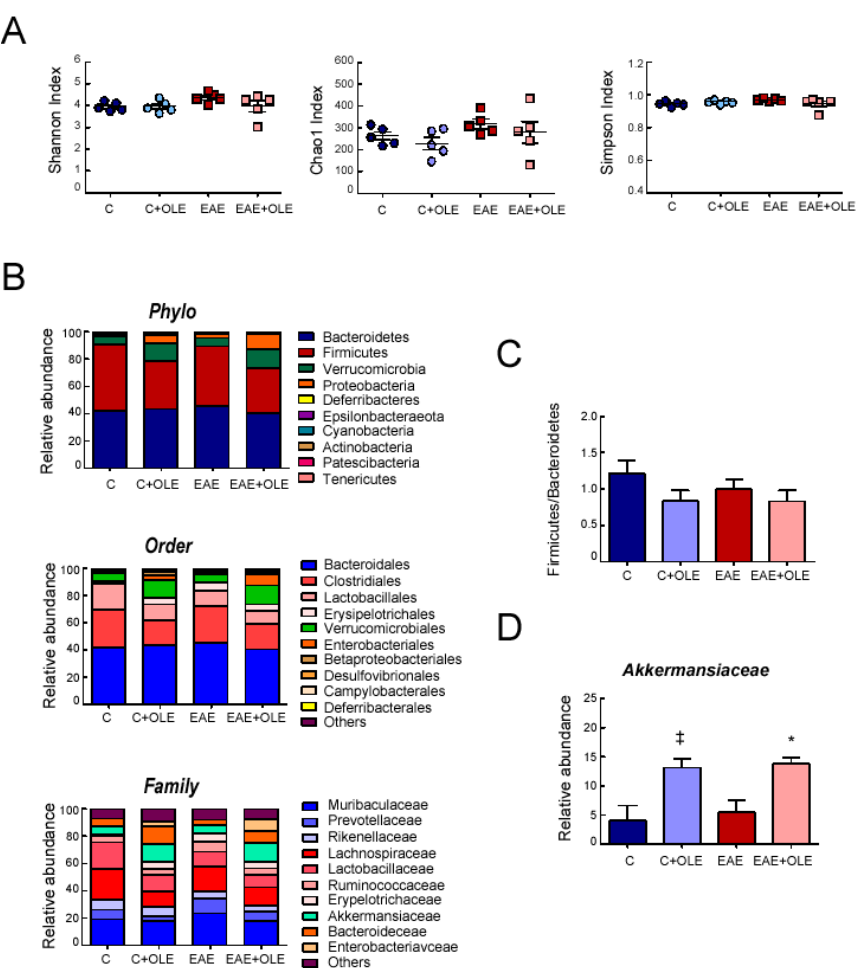
Figure 6. Effect of OLE treatment on intestinal microbiota of mice . ( A ) Alpha-diversity of the gut microbiota using Shannon, Simpson and Chao indices. ( B ) Bar chart regarding the distribution of the most abundant phyla, orders, and families. The proportion of stack in the bar chart corresponds to the total amount of reads of the most abundant phyla, orders and families. ( C ) Firmucutes / Bacteriodetes ratio ( D ) Relative abundance of Akkermansiaceae . Data are the mean ± SEM, n = 5 per group. ‡ p < 0.05 vs . control; and * p < 0.05 vs . untreated EAE. C, healthy mice. C + OLE, healthy mice treated with OLE. EAE, induced mice. EAE + OLE, induced mice treated with OLE.